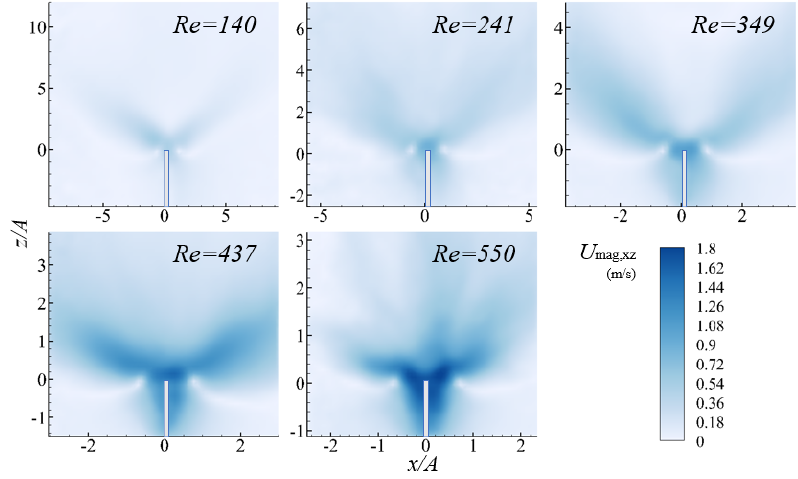
Figure 7. Time-averaged velocity magnitude ( U mag, xz ) field in the transverse plane ( x - z plane) at different Reynolds numbers.